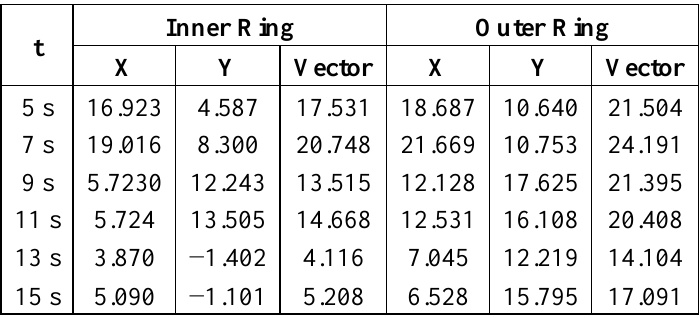
Table 4. Displacement vectors